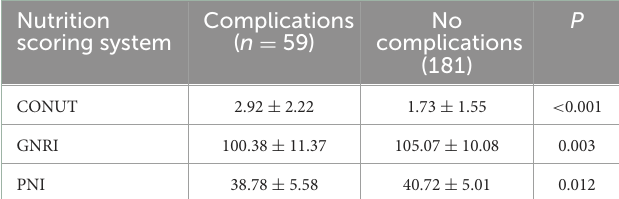
TABLE 3 Relationship between CONUT score, GNRI score, PNI score and postoperative